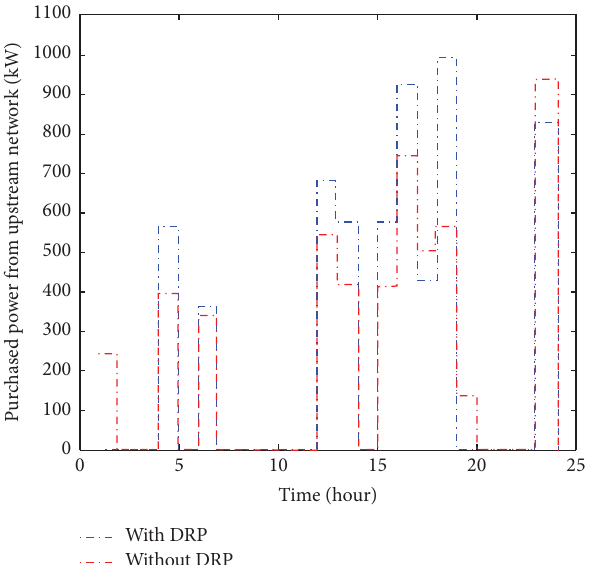
Figure 10: Power purchased from the upstream network.